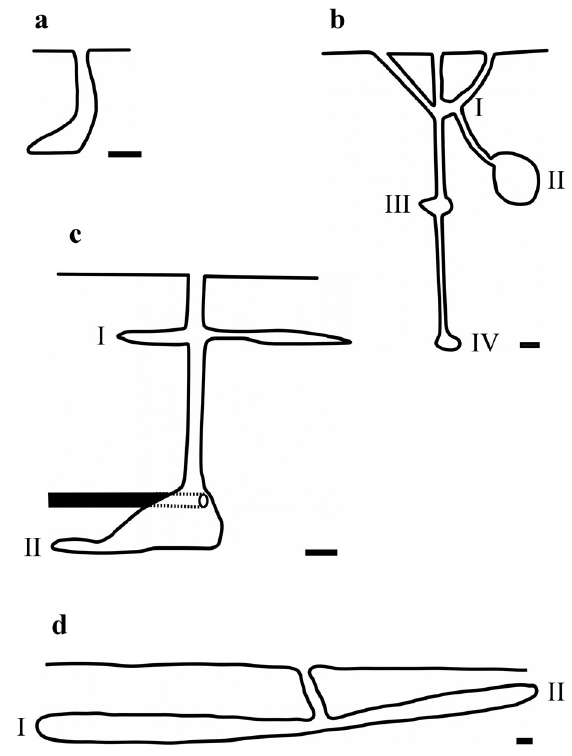
Fig 1 . Neoponera verenae architecture nests. a: Nv1, b: Nv2, c: Nv3, d: Nv4. Scales 2 cm.